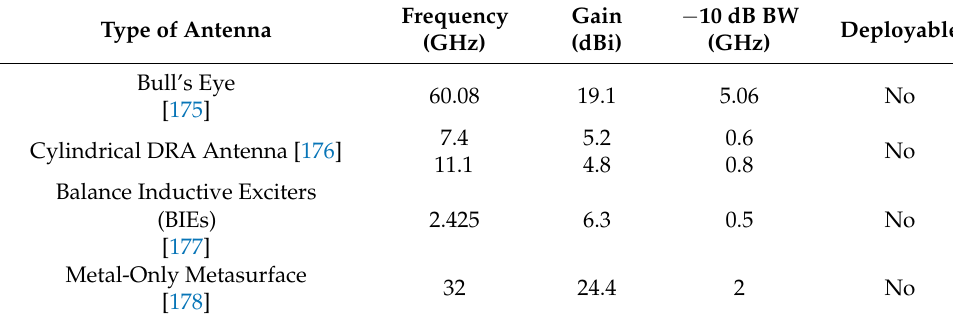
Table 10. Performance of other